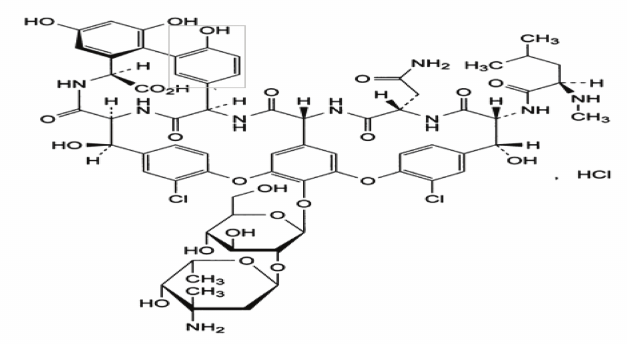
Figure 1 - Chemical structure of vancomycin